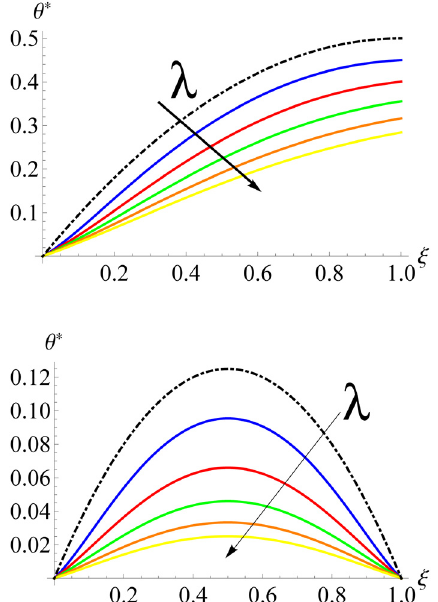
Figure 2. Doubly